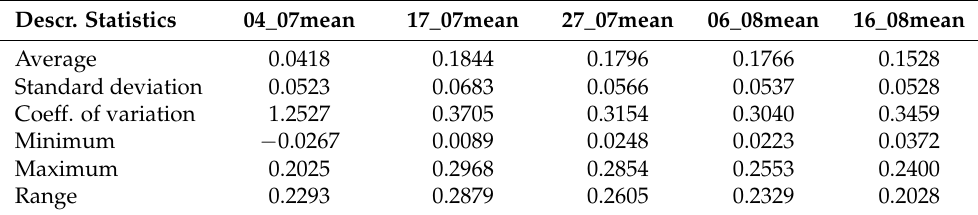
Table 4. The descriptive statistics of the WDVI mean values across all pilot fields during each data collection date.